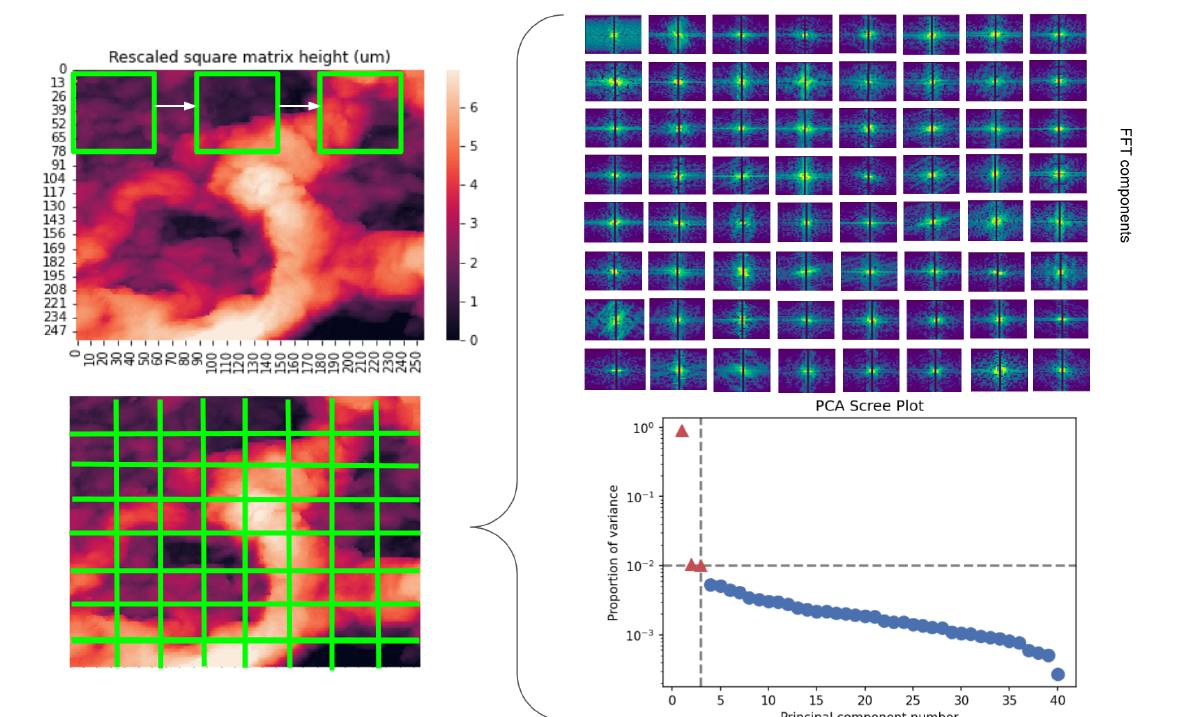
Figure 10. Graphical presentation of the height image RPCA analysis method. The height image is split in tiles ( left ) from which each FFT spectrum is computed ( top right ). The spectrums are fed to the RPCA algorithm from which we can obtain the number of components from the PCA scree plot ( bottom right